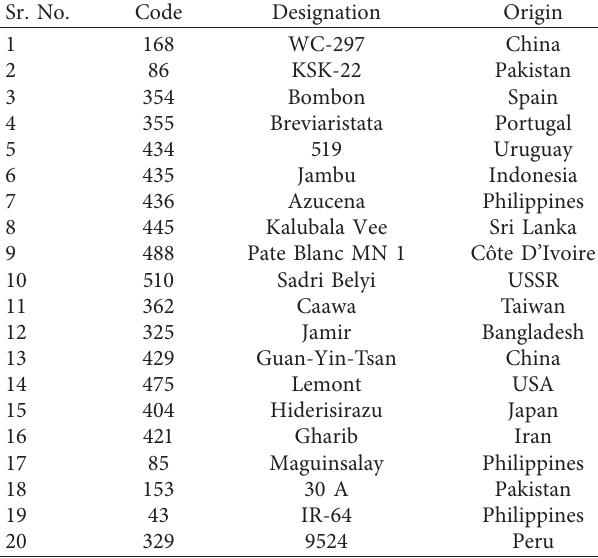
Table 1: Drought-responsive genotypes 1–10 are DT, 11–15 are MDT, and 16–20 are